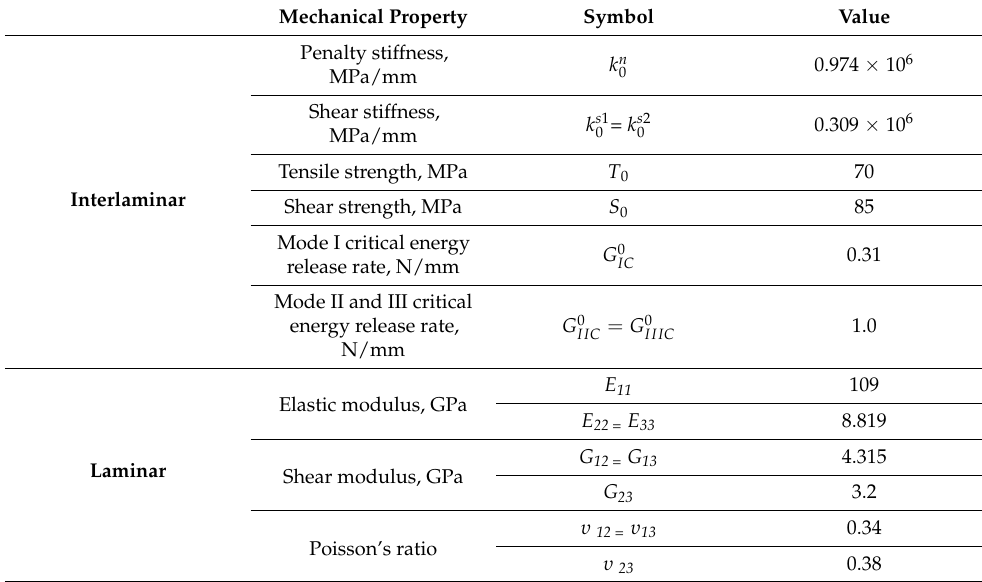
Table 1. Reference quasi-static lamina and interlaminar properties of CFRP composite laminates extracted based on [46,47].